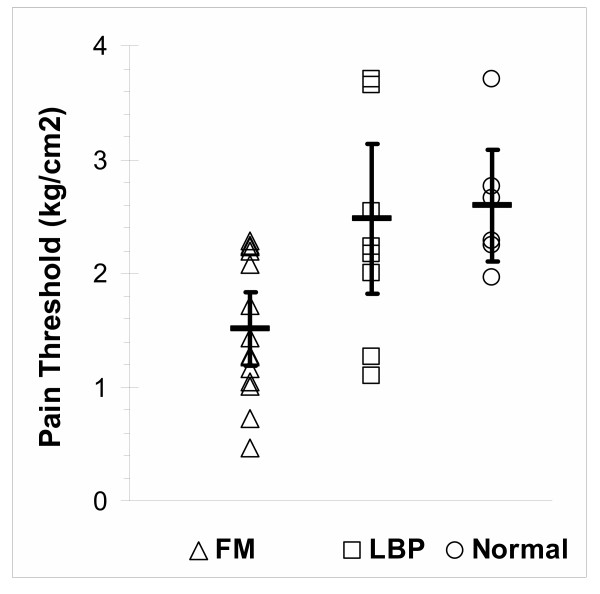
Pressure pain thresholds (kg/cm2) determined by dolorimetry. Pain thresholds for FM (triangles) were significantly lower than LBP (squares; p = 0.009) and Normal (circles; p = 0.002) groups. The bars indicated means and 95% confidence intervals.